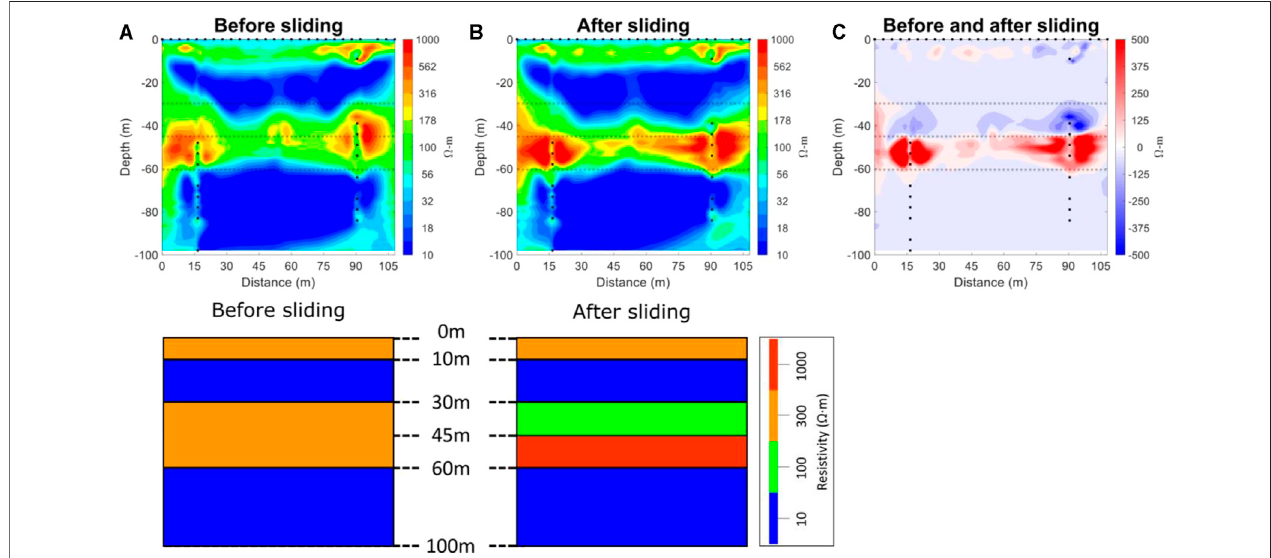
FIGURE 14 | Numerical modeling to test the resolving capability of the ERT electrode array used in the fi eld. We assume that, due to a hypothetical sliding event, the shallower part of the mid-high-resistivity layer in the depths between 30 and 60 m became more conductive and the deeper part more resistive. Shown in (A) and (B) are the synthetic resistivity (lower panels) and their inverted (upper panels) models before and after, respectively, the sliding event. (C) Differences in time-lapse ERT images can recover the underground changes, caused by that hypothetical event, in electrical resistivities as we observed in the fi eld